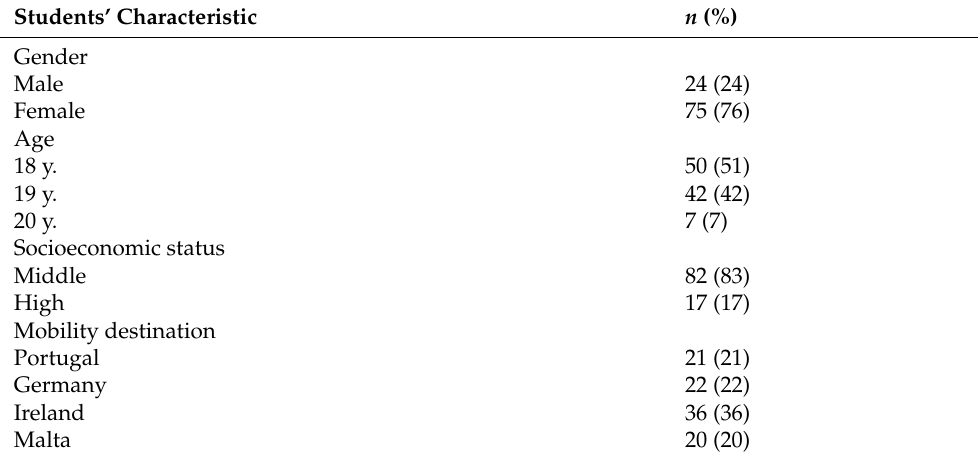
Table 1. Sociodemographic characteristics of participants ( n =